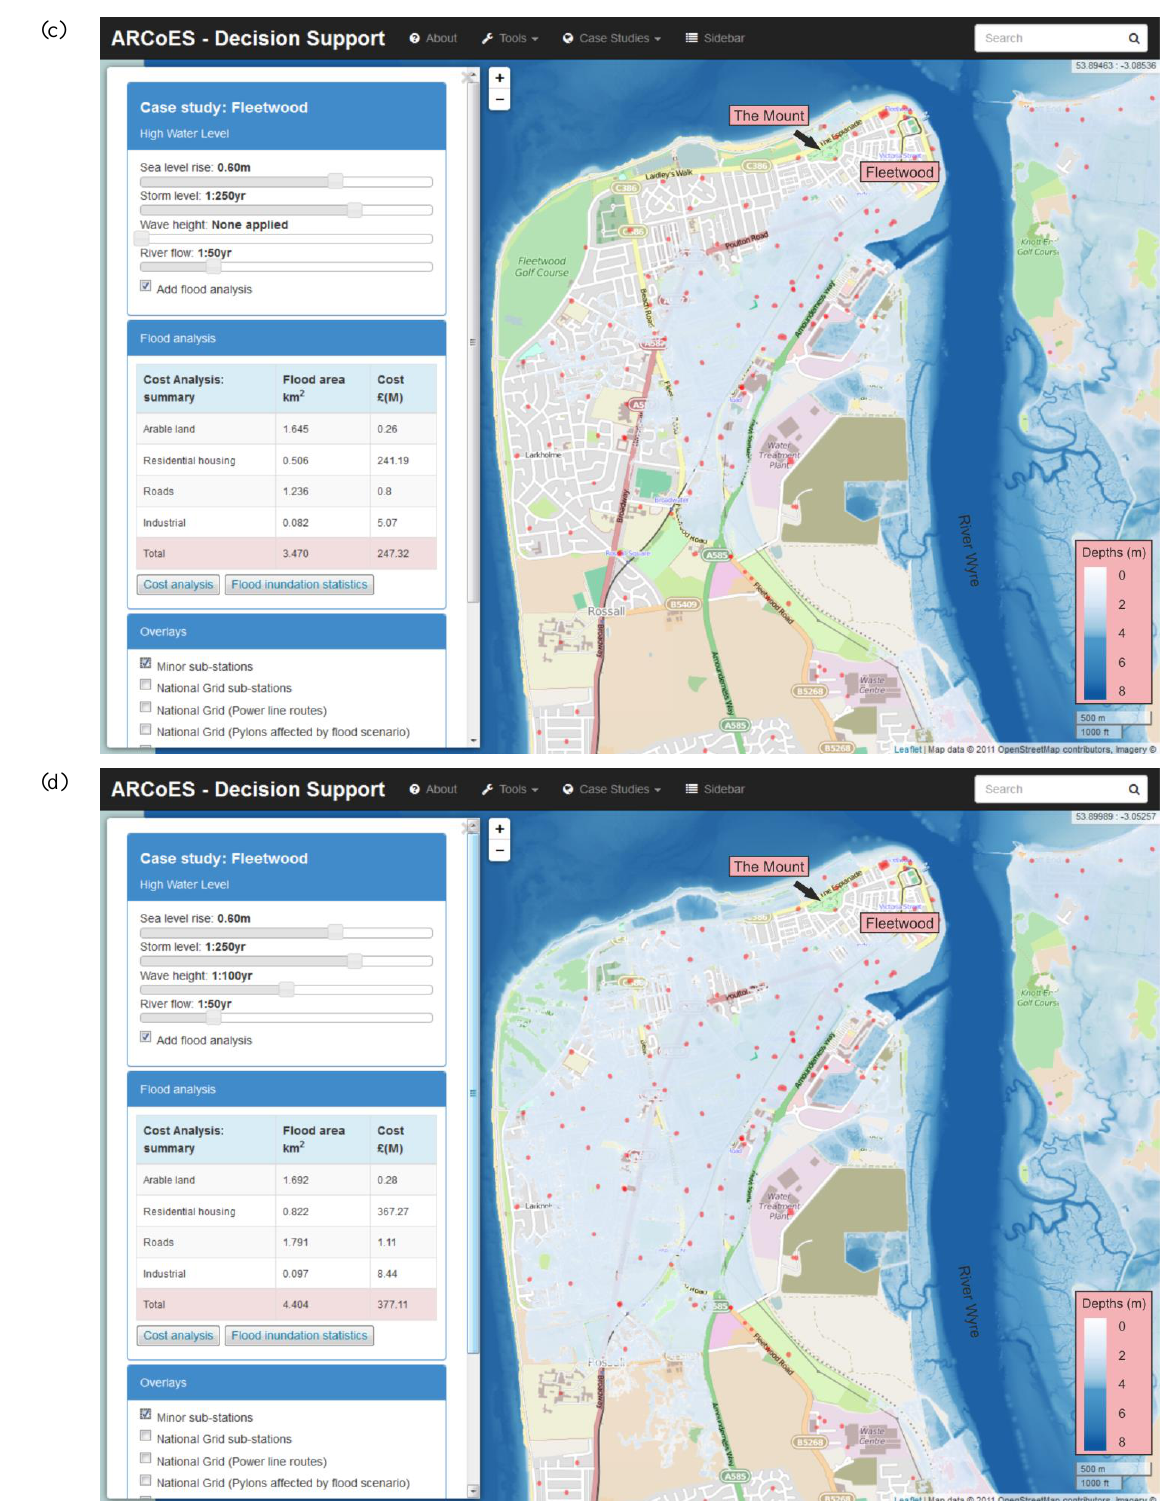
Figure 2. (c) DST screen shot of the scenario with a 0.6m sea-level rise, a 1:250 year storm level (extreme water level), and 1:50-year river flow (extreme river level). Note: labels with dark-pink backgrounds have been added to screen shot. (d) DST screen shot of the scenario with a 0.6m sea-level rise, a 1:250 year storm level (extreme water level), a 1:100 year wave height (extreme wave height), and 1:50-year river flow (extreme river level). Note: labels with dark-pink backgrounds have been added to screen